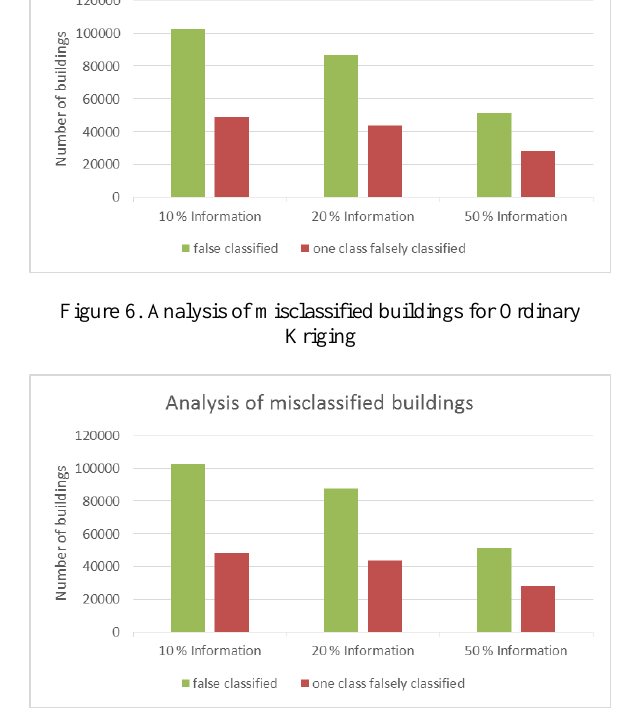
Figure 7. Analysis of misclassified buildings for Universal